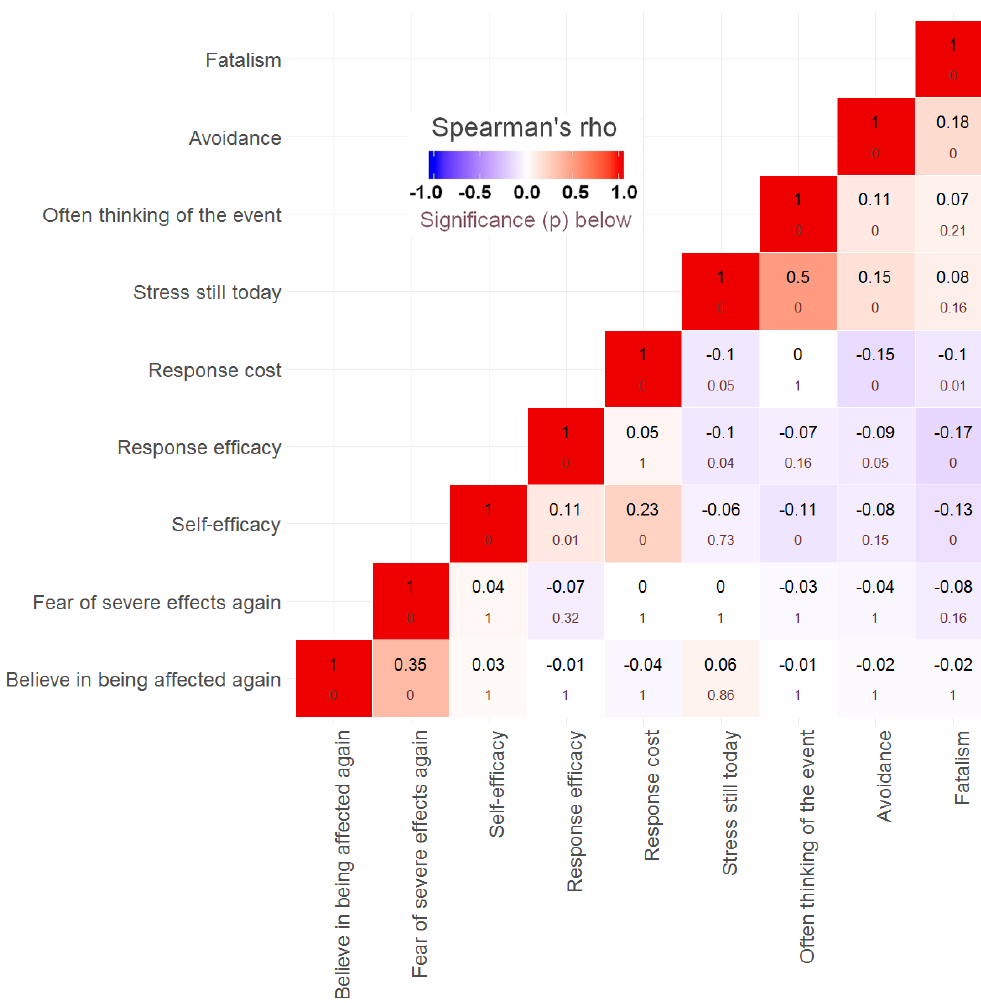
Figure A3. Correlation table of single psychological variables for river